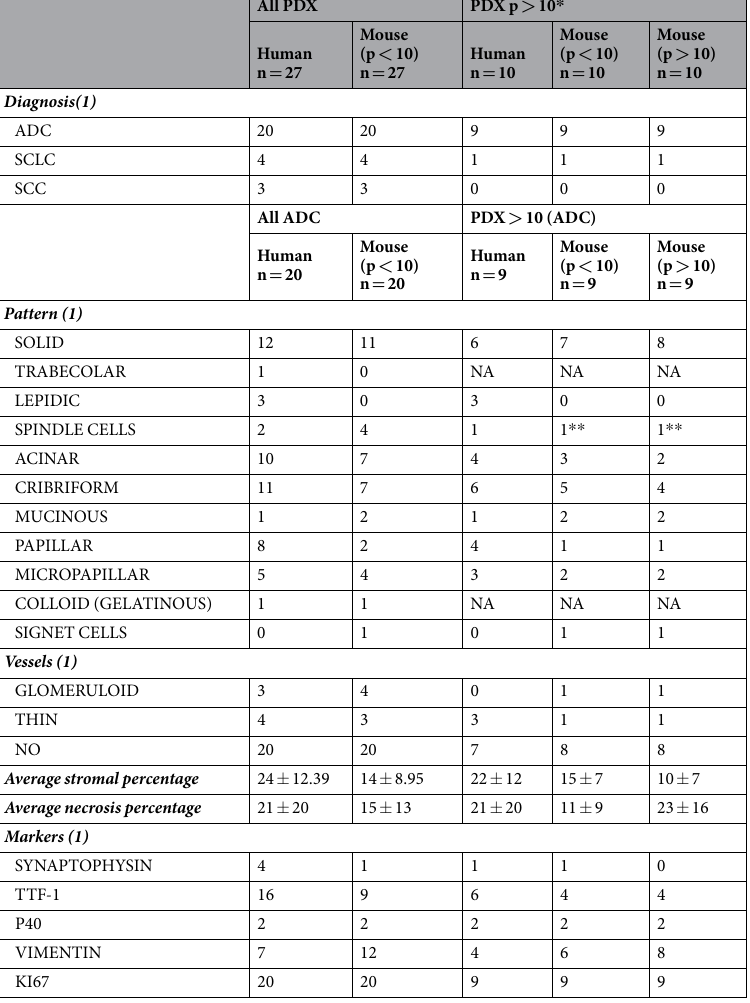
Table 3. Patients and tumours histopathological analysis. (1) Number of positive models; * Analysis of 10 PDXs that reached P > 10 in mouse; ** Resulting from a pattern loss in one PDX and a pattern acquisition in another